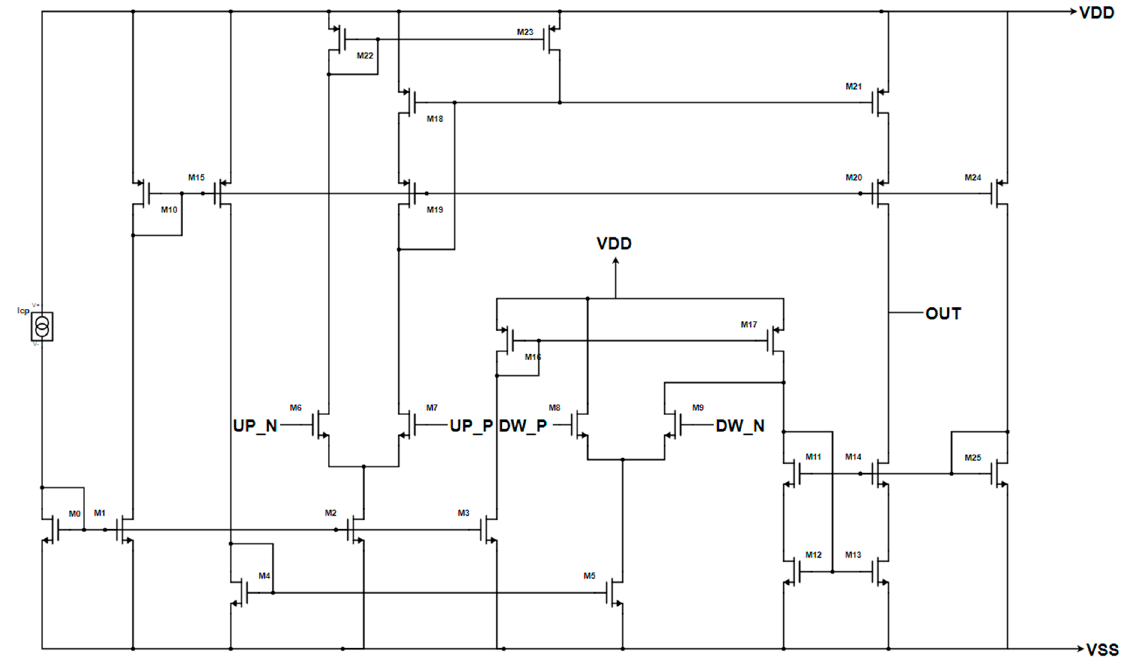
Figure 11. Enhanced CP’s Gate Switching architecture with differential inputs.